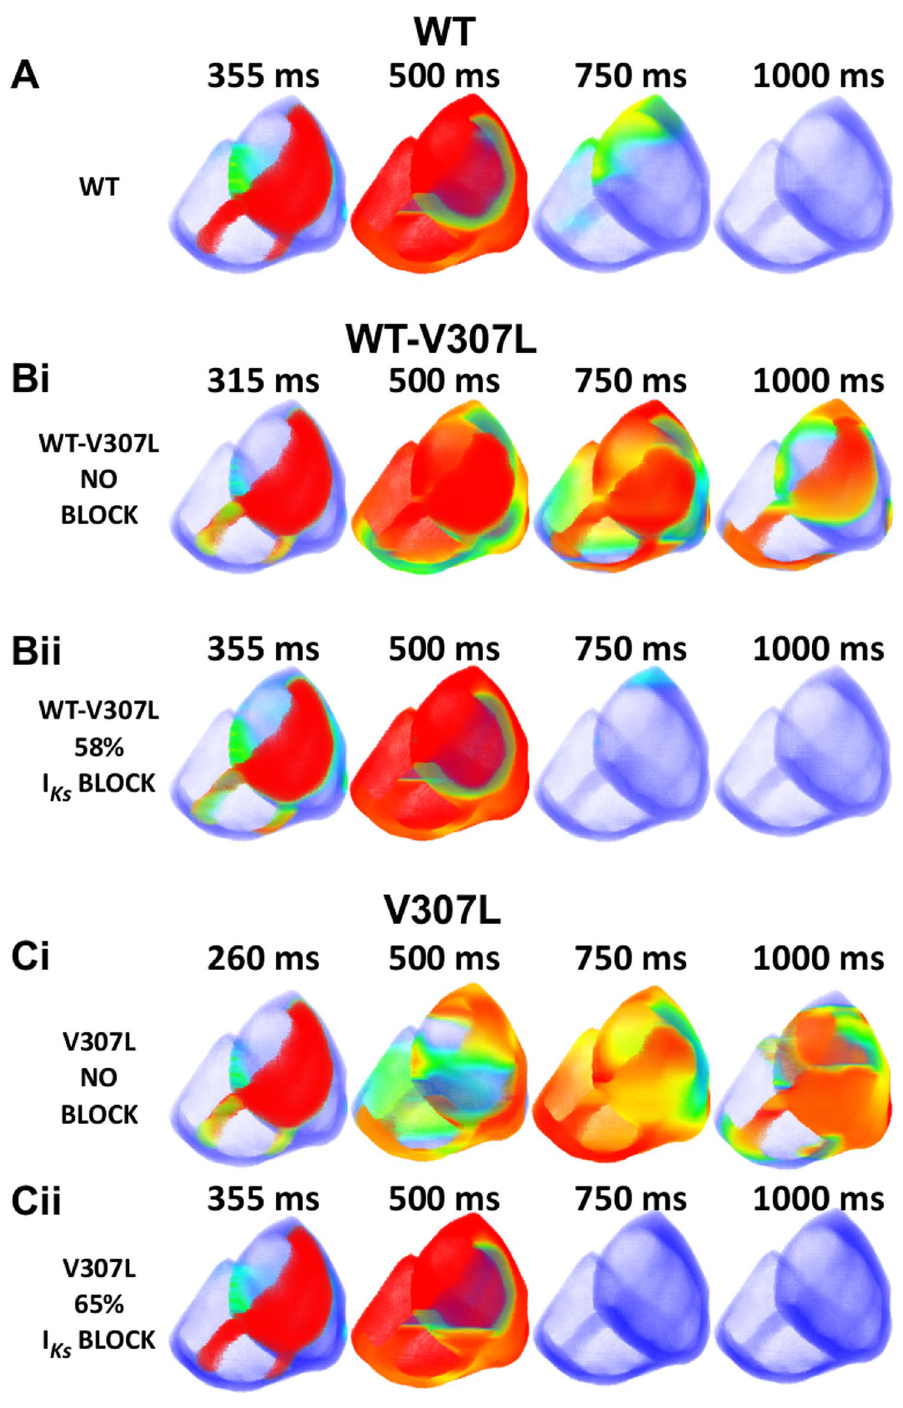
Figure 8. Termination of re-entry in 3D ventricle model by I Ks blockade. ( A ) Application of a premature S2 stimulus in a local region of WT tissue during the refractory period (355 ms) leads to the development of a scroll wave (500 ms) that terminates in under 1000 ms. ( Bi ) Application of a premature S2 stimulus in a local region of WT-V307L tissue during the refractory period (315 ms) leads to the development of a scroll wave (500 ms) which persists beyond 1000 ms. ( Bii ) Application of a premature S2 stimulus in a local region of WT- V307L tissue with 58% I Ks blockade during the refractory period (355 ms) leads to the development of a scroll wave (500 ms) that terminates in under 1000 ms. ( Ci ) Application of a premature S2 stimulus in a local region of V307L tissue during the refractory period (260 ms) leads to the development of a scroll wave (500 ms) which persists beyond 1000 ms. ( Cii ) Application of a premature S2 stimulus in a local region of V307L tissue with 65% I Ks blockade during the refractory period (355 ms) leads to the development of a scroll wave (500 ms) that terminates in under 750